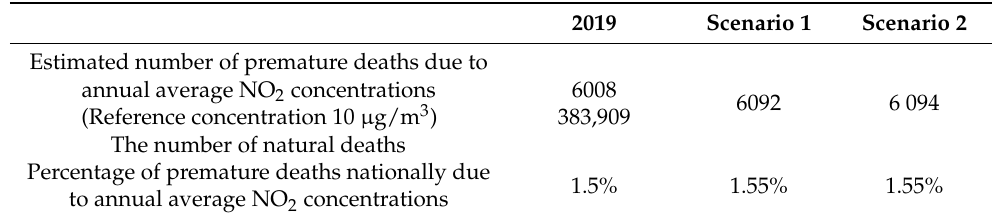
Table 5. Estimated number of premature deaths nationally due to annual average NO 2 concentrations in 2019 and based forecasts on scenario 1 and scenario